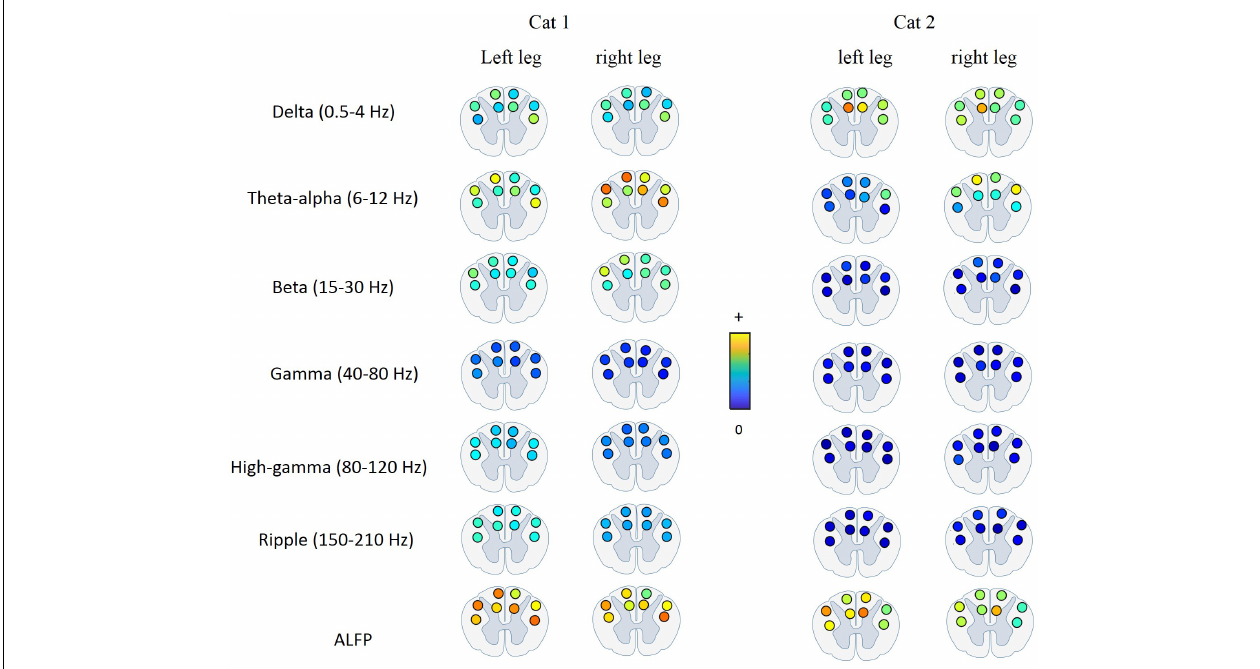
FIGURE 9 | Average of mutual information between the LFP signal at each frequency band and each joint angle for different electrode positions in the spinal cord. The most kinematic information is represented by the low-frequency components. There is no significant difference between the kinematic information of the signals recorded from the DC and LC